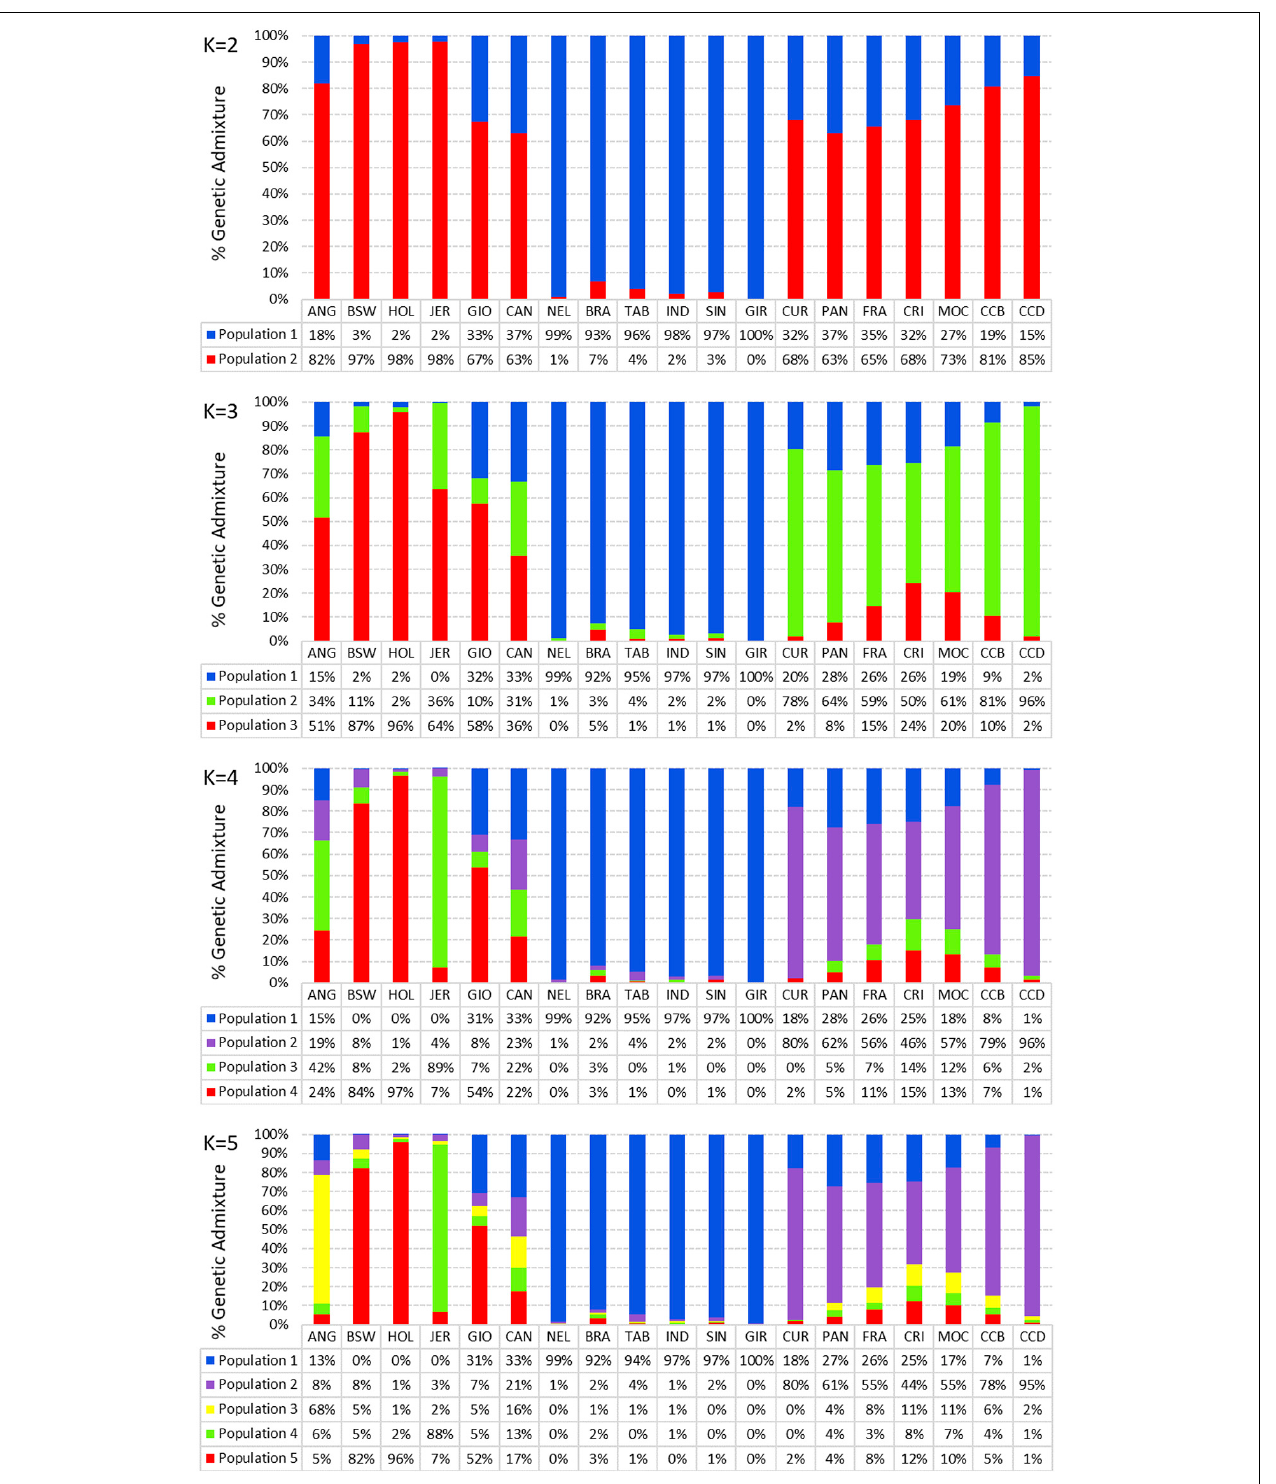
FIGURE 5 | Breed composition of nineteen cattle breeds raised in Brazil. Admixture analysis using the first 5 K solutions for 19 populations grouped by taurine, synthetic crossbreed, indicine, and locally adapted animals. ANG, Angus; BWS, Brown Swiss; JER, Jersey; HOL, Holstein; BRA, Brahman; GIR, Gir; IND, Indubrasil; NEL, Nelore; SIN, Sindhi; TAB, Tabapuã; CCD, Caracu Dairy; CCB, Caracu Beef; CRI, CriouloLageano; CUR, CurraleiroPé-Duro; FRA, CriouloLageano do RS; MOC, MochoNacional; PAN, Pantaneiro; CAN, Canchim; GIO, Girolando.